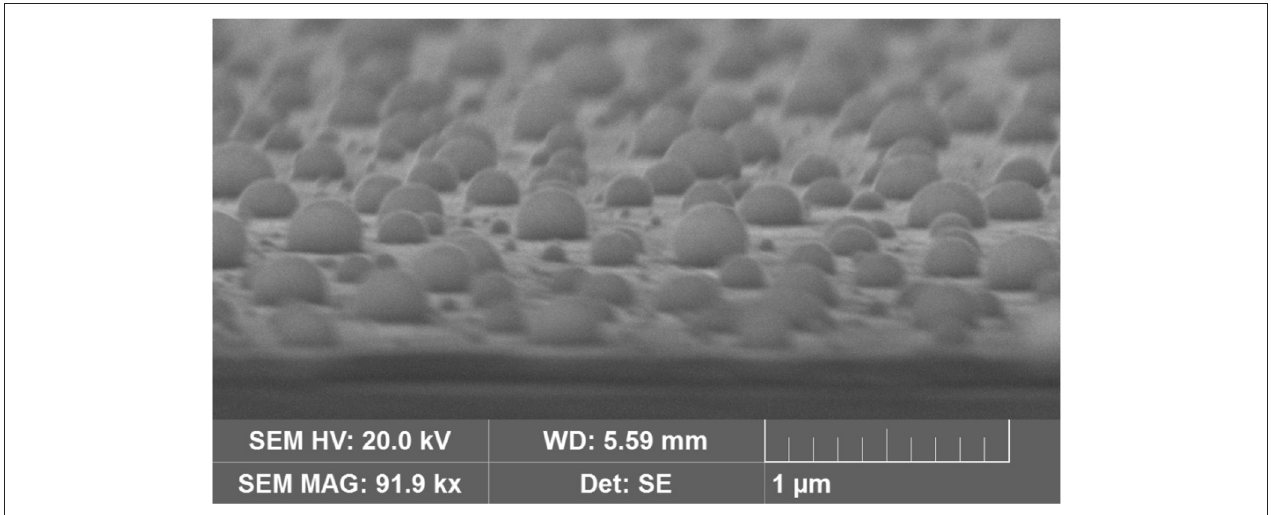
FIGURE 2 | SEM images of AuNPs obtained from 40nm Au film thickness after tilting the sample by 80 ◦ C.